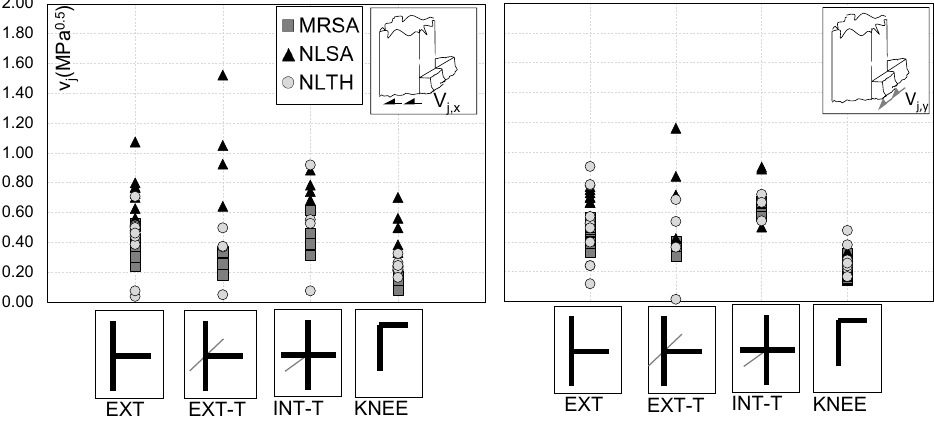
Figure 19. Shear demand of beam–column joints of SPEAR frame as a function of the joint